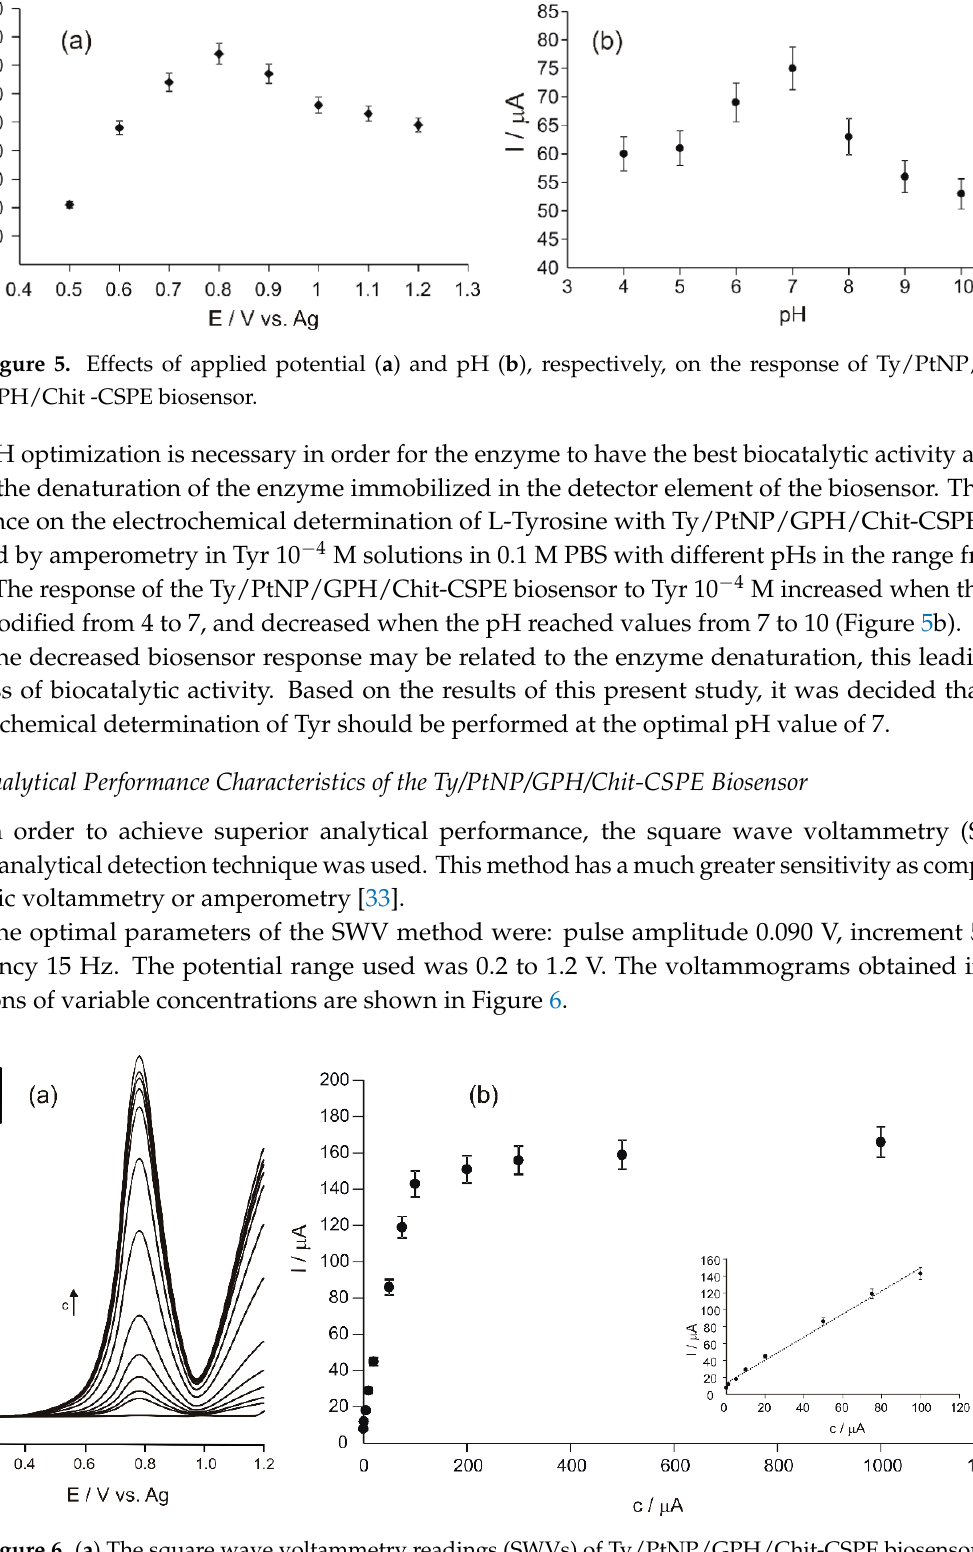
Figure 6. ( a ) The square wave voltammetry readings (SWVs) of Ty/PtNP/GPH/Chit-CSPE biosensor immersed in Tyr solution with different concentrations ranging from 1 × 10 − 7 to 1 × 10 − 3 M; ( b ) the dependence between the peak current values and the concentration values (calibration curve). B inset — the linearity range.